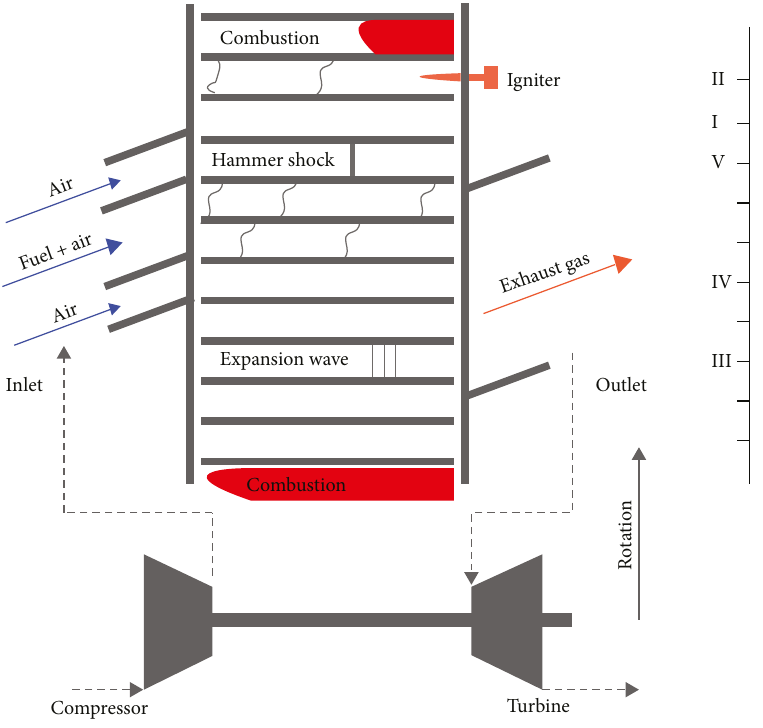
Figure 2: Illustration of the operating process for WRC. Table 1: Summary of common detailed chemical reaction mechanisms of